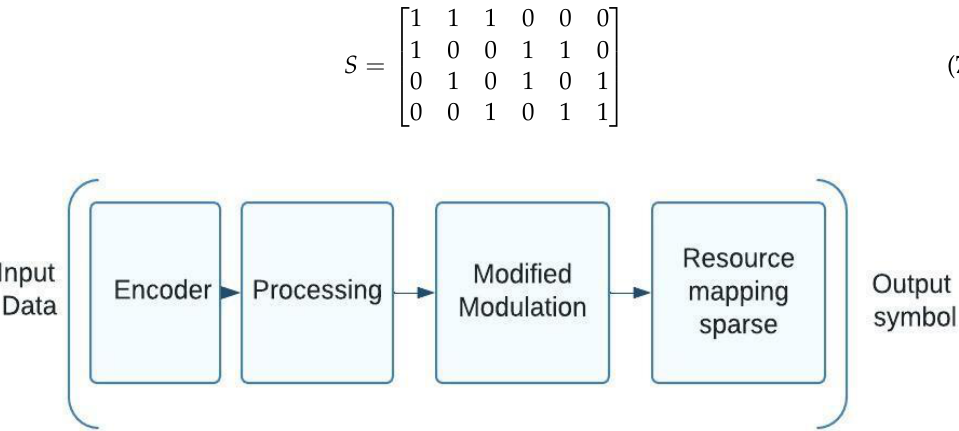
Figure 6. Sparse pattern and modified 5G modulation NOMA system structure.